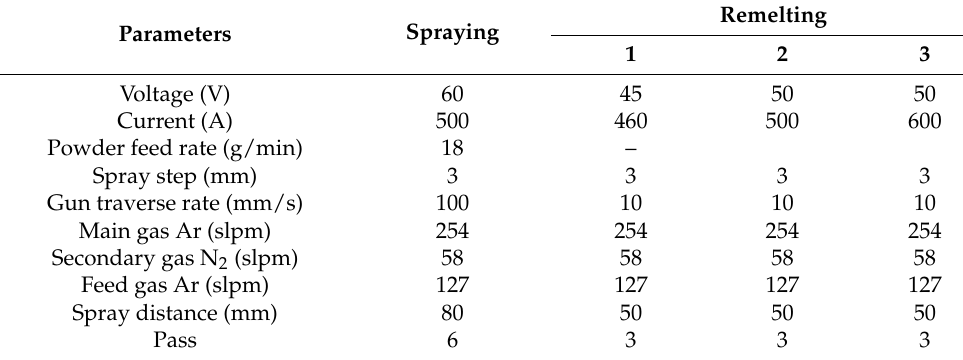
Table 2. Plasma spraying and remelting parameters selected.